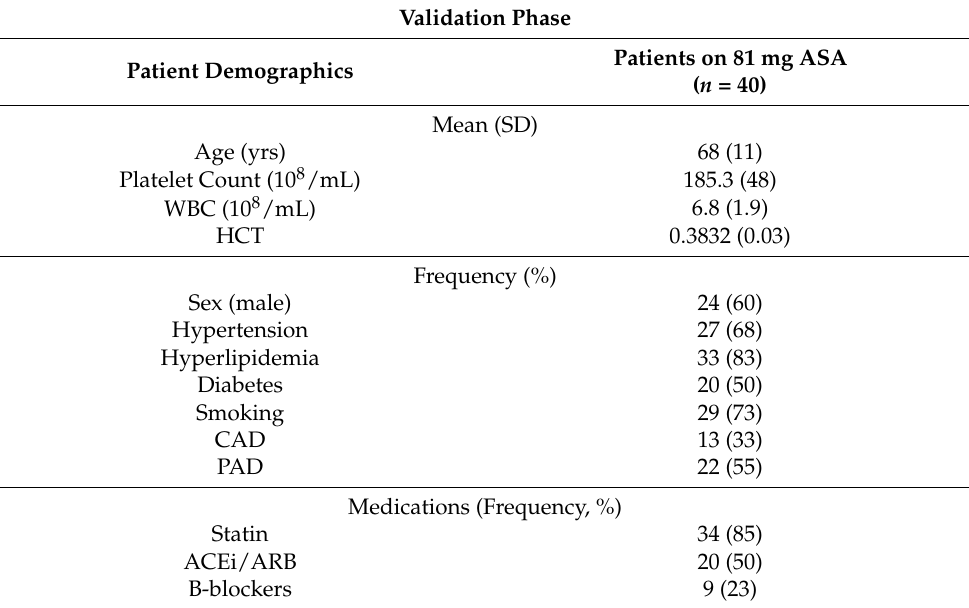
Table 2. Baseline characteristics of patients recruited for the validation phase of the